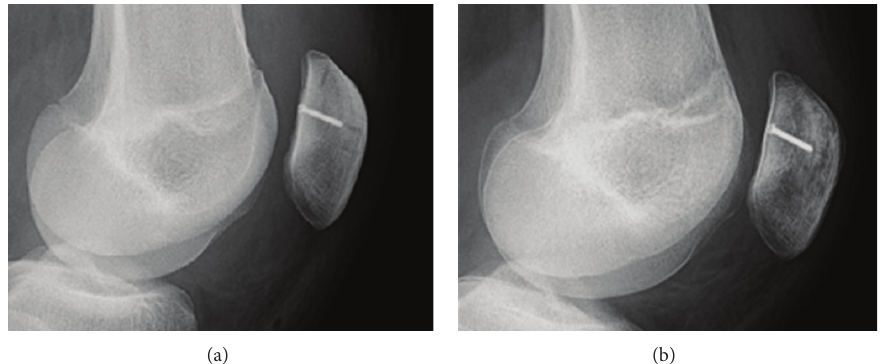
Figure 4: Serial axial radiographs of the patella after screw refixation of an osteochondral flake fracture in a 17-year-old patient. Followup imaging after operation (b) shows osteopenia with a subchondral predelication, this is in clear contrast to the immediately postoperative radiograph (a).